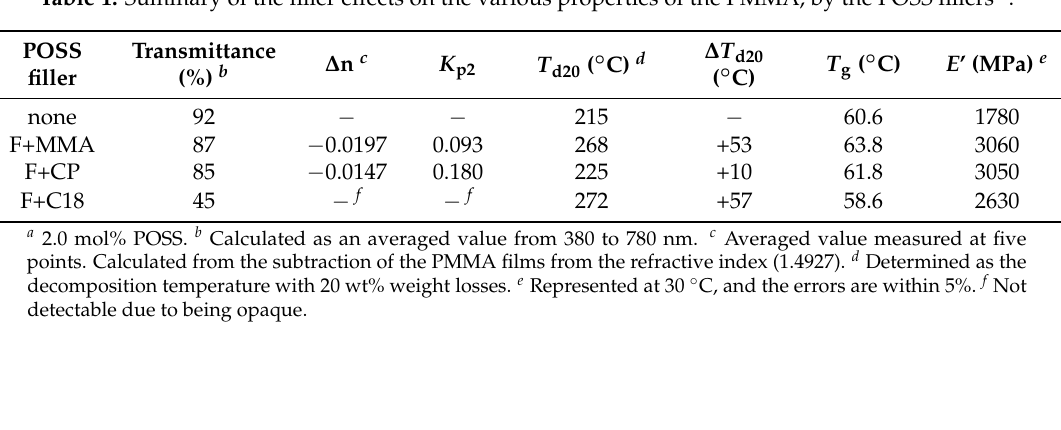
Figure 1. Appearances of the poly(methyl methacrylate) (PMMA) hybrid films with 2 mol% POSS fillers.